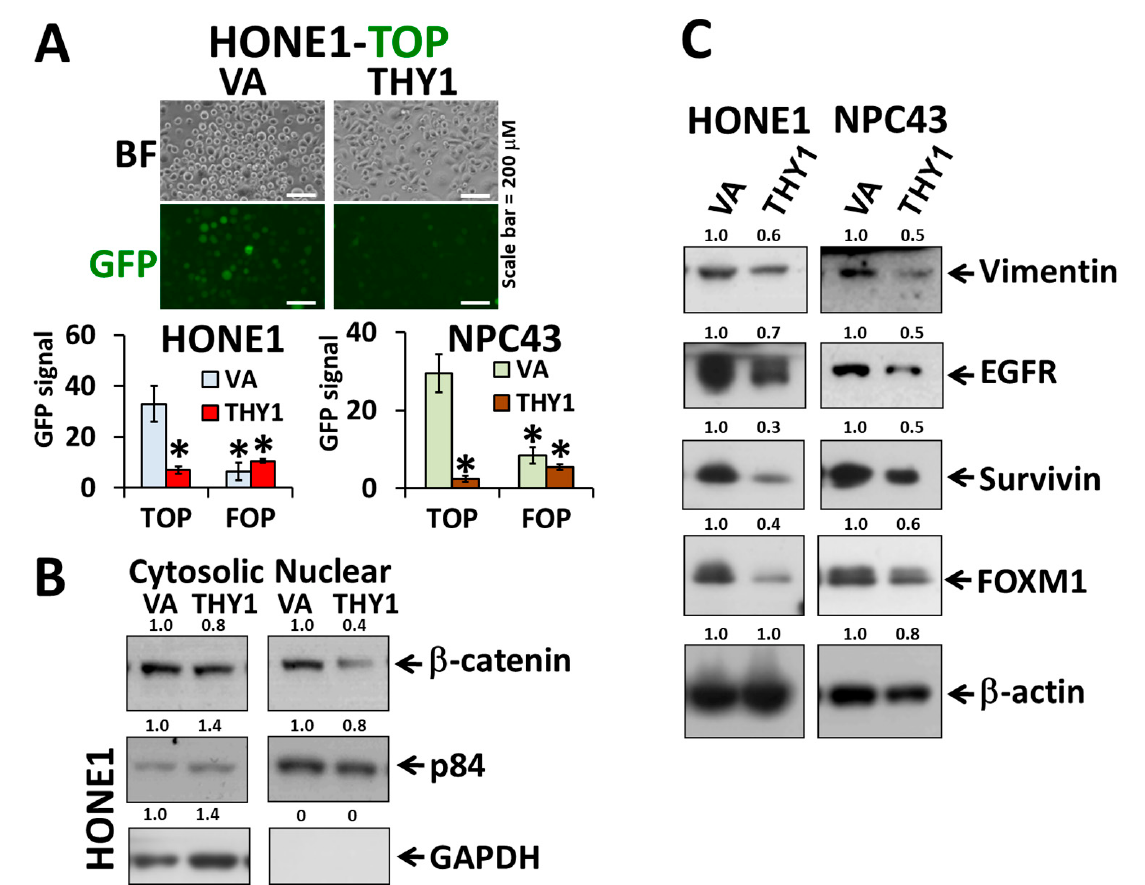
Figure 2. THY1 reduces the level of cytosolic β -catenin and inhibits the Wnt signaling pathway. ( A ) Representative results of TOP/FOP-FLASH assay (top photo) and statistics of the TOP/FOP-FLASH assay in HONE1 and NPC43 cells. Wnt signals are reflected by average GFP intensities in HONE1 and NPC43 with forced expression of THY1. *: p < 0.05 compared with VA-TOP; VA, vector-alone. ( B ) Western blot analysis of nuclear and cytosolic β -catenin in THY1 tranductants. ( C ) Western blot analysis of the EMT and Wnt target proteins in THY1-expressing cells.